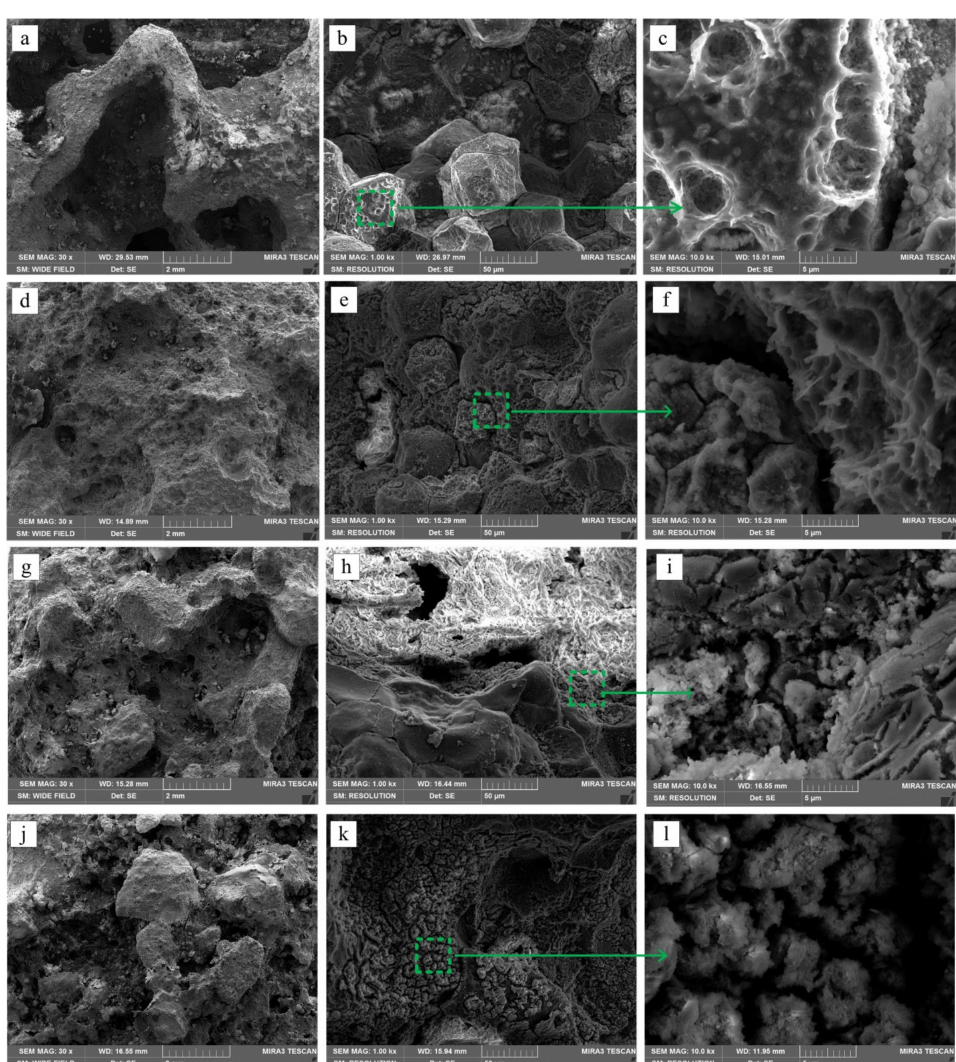
Figure 8. The surface morphologies of composites after 15 days in SBF solution after removal of corrosion products: ( a – c ) ZK61, ( d – f ) ZK61/5 β -TCP, ( g – i ) ZK61/10 β -TCP and ( j – l ) ZK61/15 β -TCP